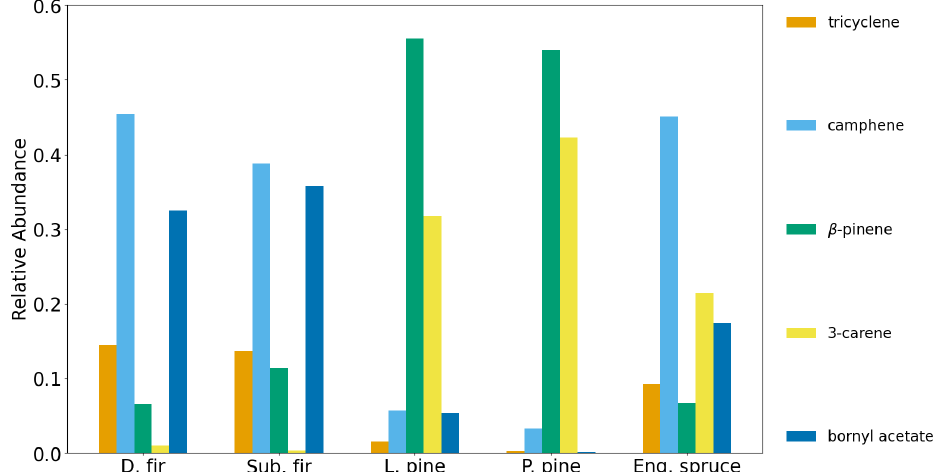
Figure 4. Normalized emission ratio profiles for Douglas fir, subalpine fir, lodgepole pine, ponderosa pine and Engelmann spruce based on automated compound